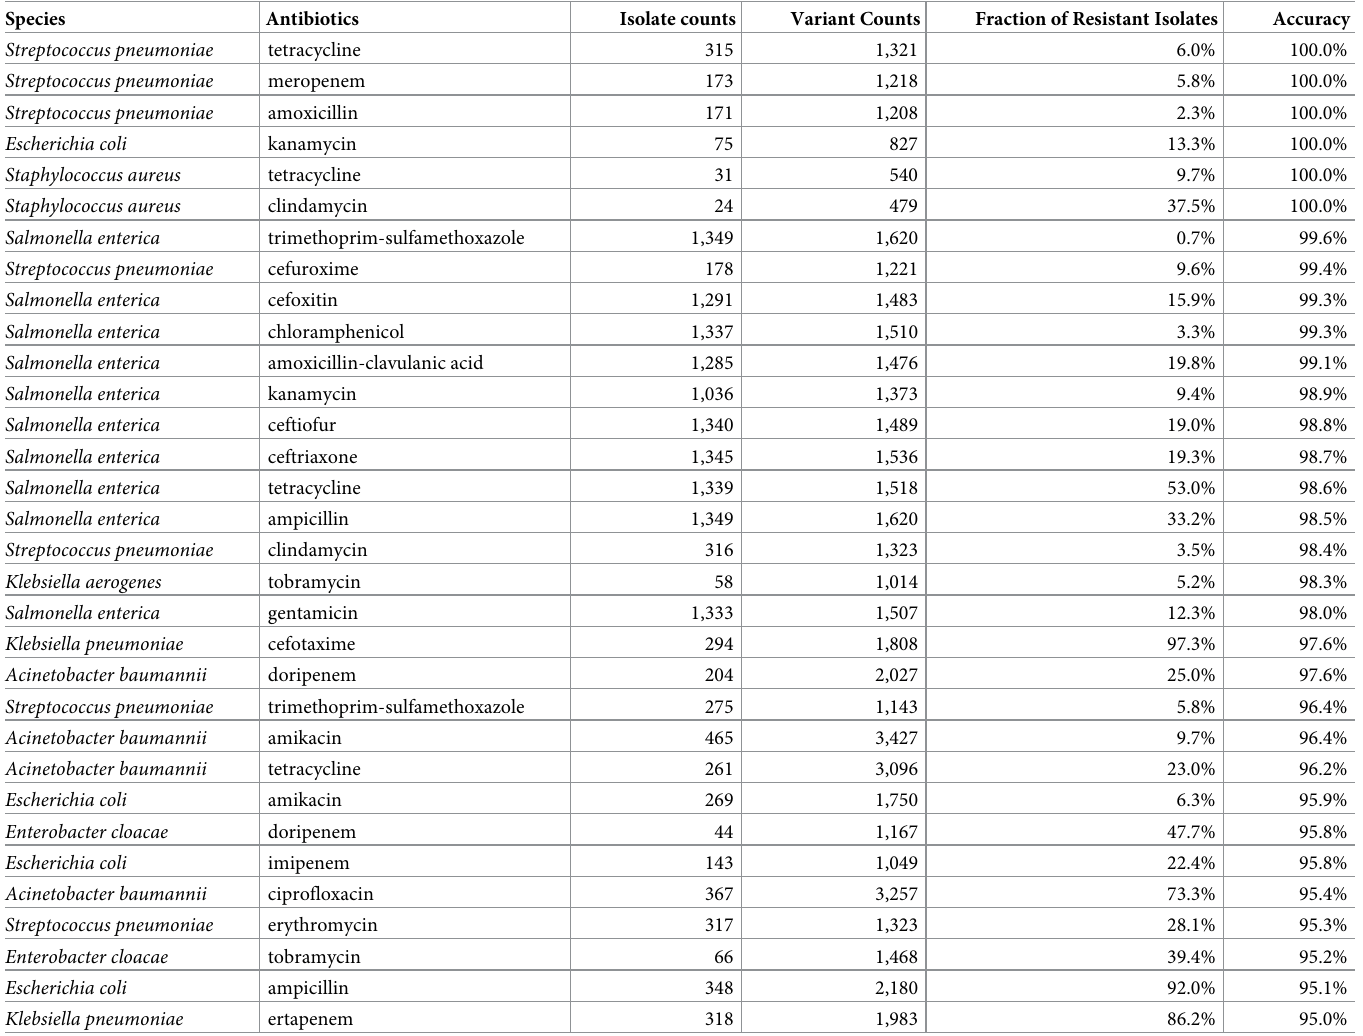
Table 1. Prediction metrics for 32 VAMPr prediction models. Among 93 prediction models, we listed the top 32 models that have the mean prediction accuracies higher than 95%. The isolate and variant counts derived from sequencing were used to build the prediction model using gradient boosting tree algorithms. The accuracy is reported using nested cross validation approach. The 10-fold outer cross validation were used to report accuracy and the 5-fold inner cross validation was used for hyper- parameter